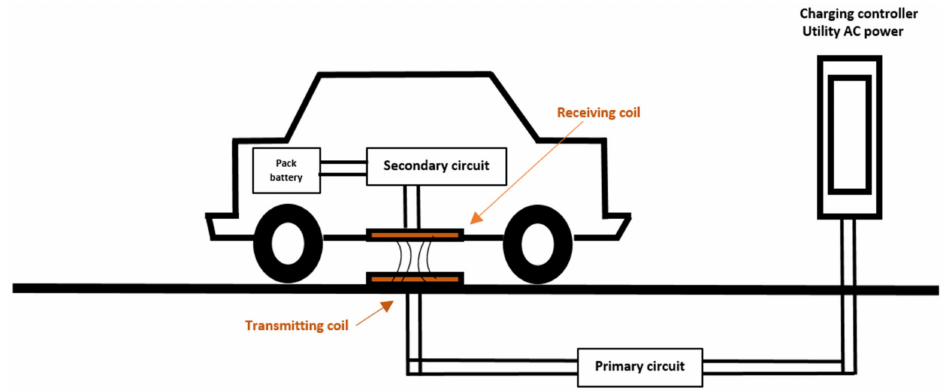
Figure 1. The concept of WPT charging for the electric